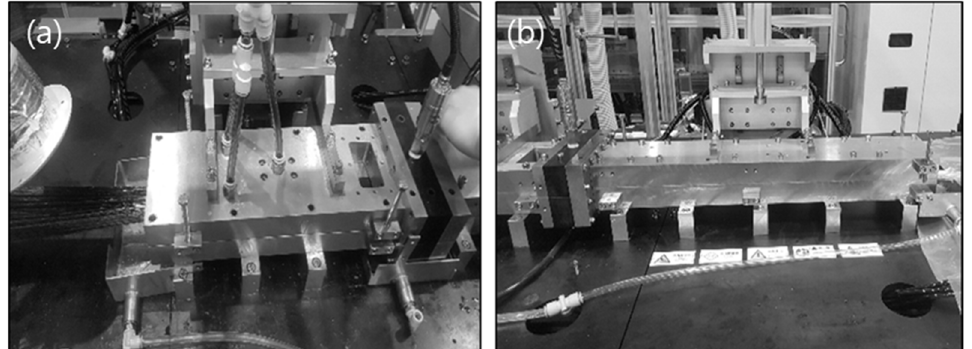
Figure 2. ( a ) Closed impregnation system and ( b ) final curing mold of the system.